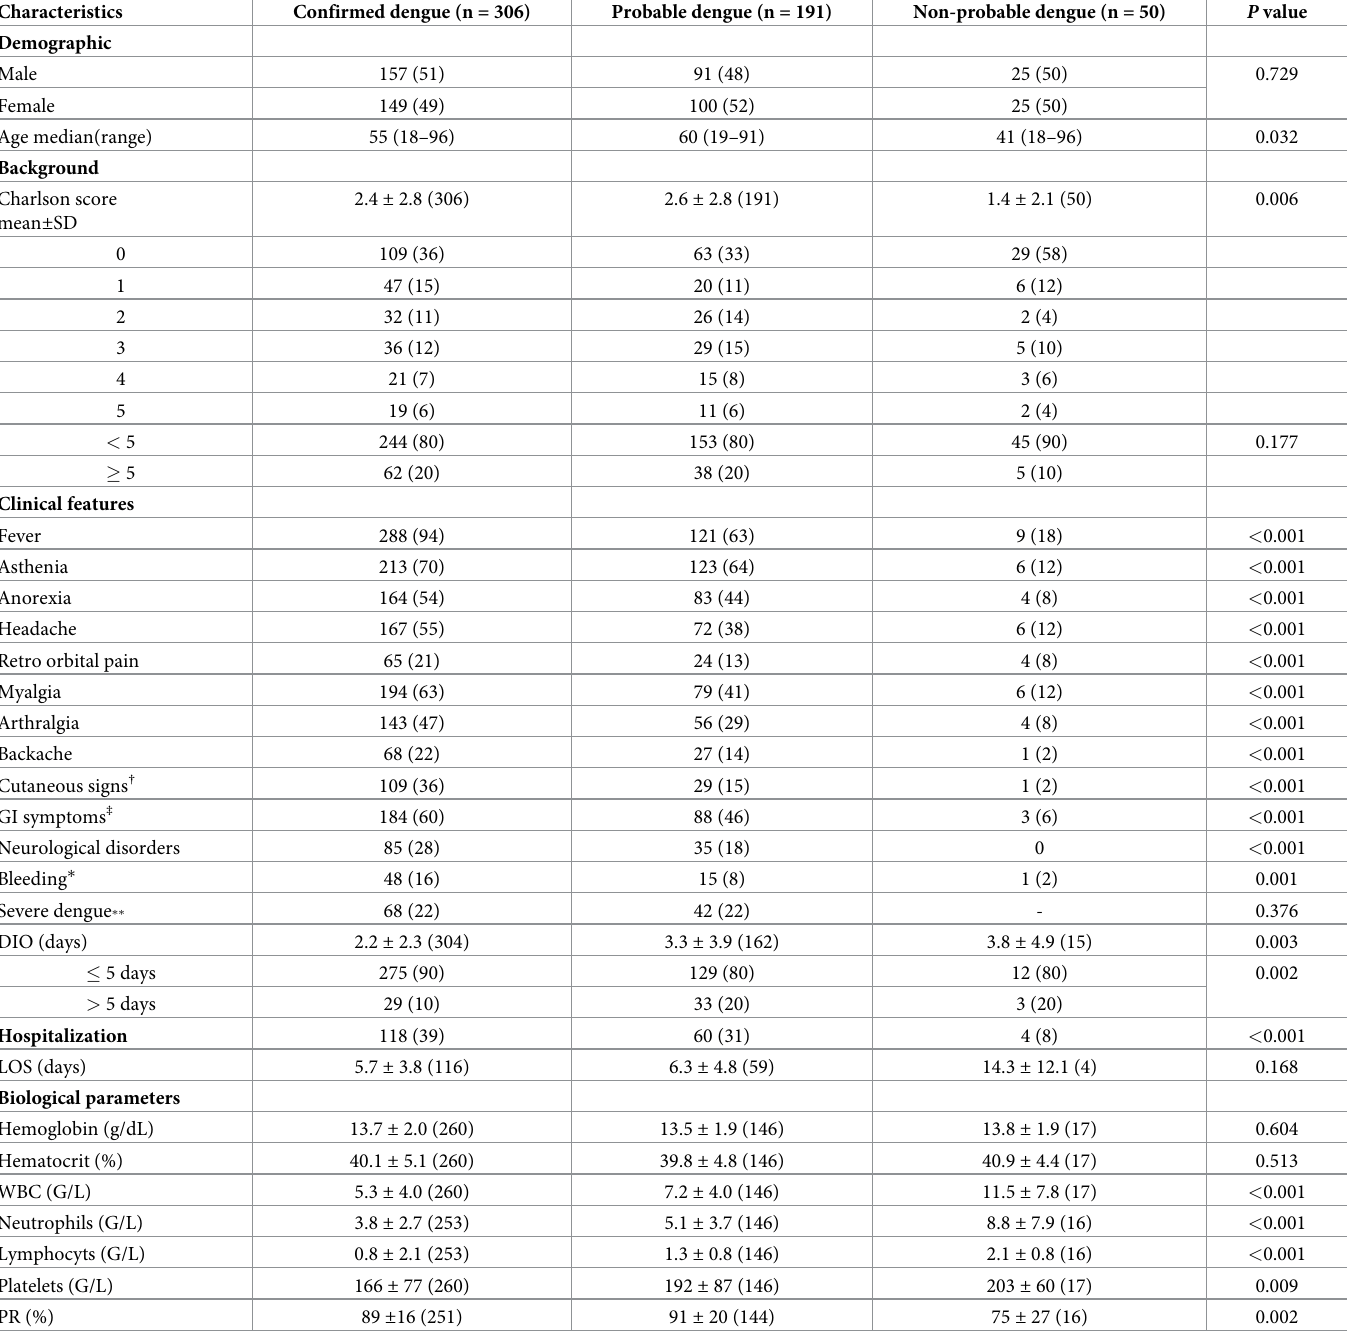
Table 1. Characteristics of study population, Reunion, 2019 (N = 671).